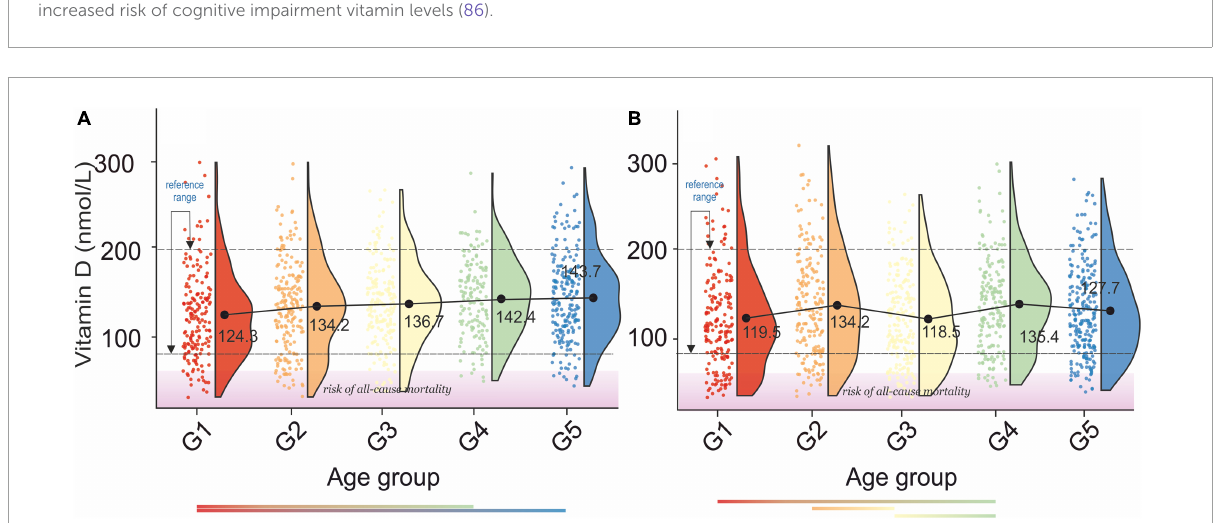
FIGURE7 Rain-cloud plots of age-dependent changes in vitamin D levels as a function of age group G1: 20 ≤ 1 < 30, G2: 30 ≤ 2 < 40, G3: 40 ≤ 3 < 50, G4: 50 ≤ 4 < 60, and 60 ≤ G5 < 70 years of age-stratified by gender (A) men, (B) women. Mean values for a specific sample are truncated to one decimal place. Color bars refer to statistically significant differences between groups at P < 0.05. Shaded area corresponds to increased risk of all-cause mortality